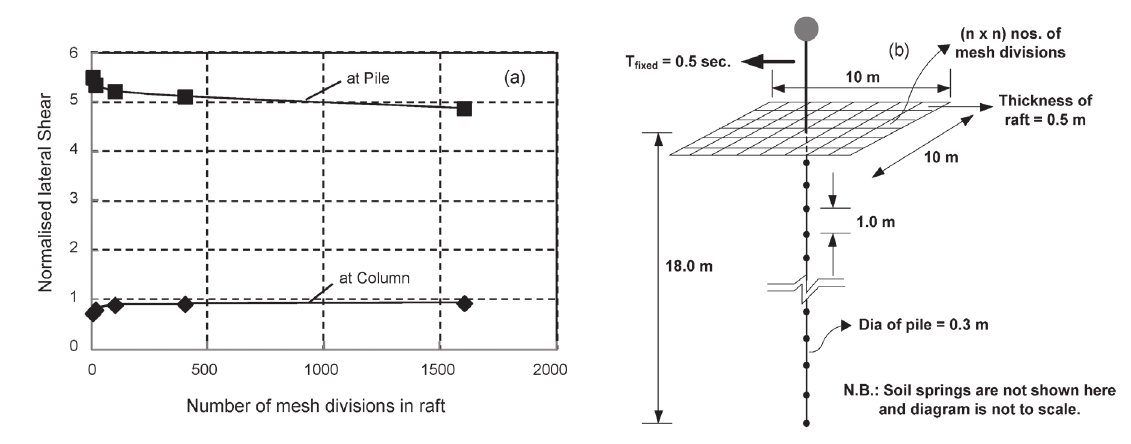
Fig. 5. Representation of mesh sensitivity results: a) normalised shear at column and pile for various choice of mesh divisions in raft; b) schematic diagram of soil-piled raft-structure system used in convergence